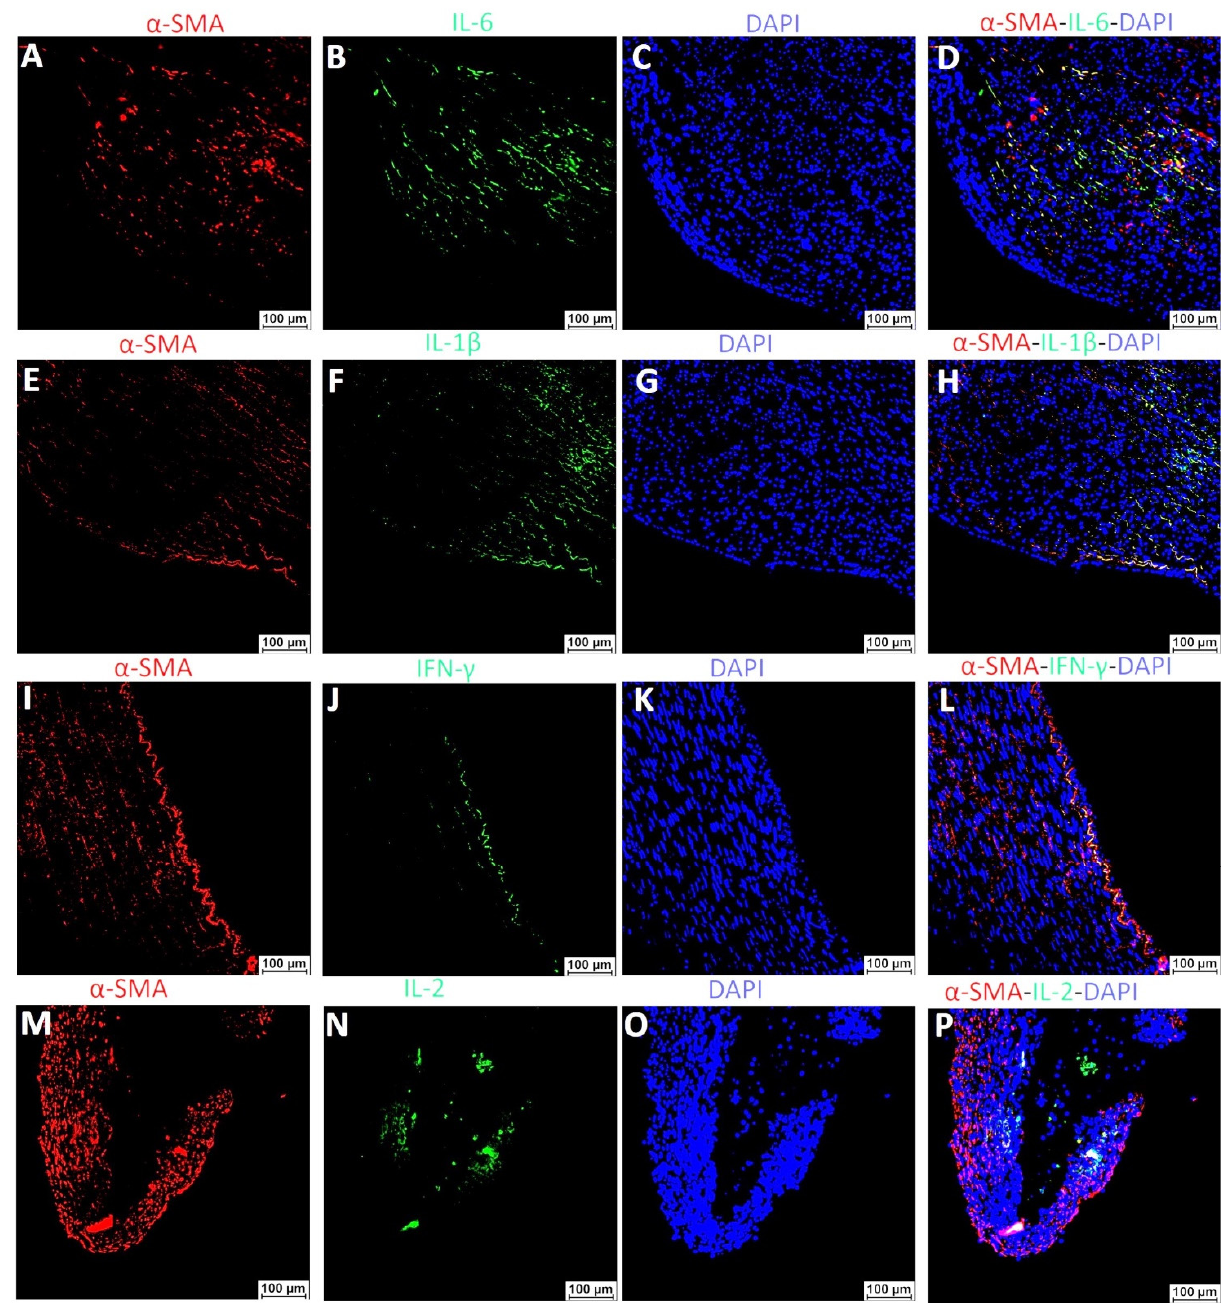
Figure 11. Dual ‐ immunofluorescence staining of arteries with a plaque for α‐ SMA and pro ‐ inflammatory cytokines IL ‐ 6, IL ‐ 1 β , TNF ‐α , and IL ‐ 2. Immunofluorescence for alpha ‐ smooth muscle actin ( α‐ SMA, panels A , E , I , M ), interleukin 6 (IL ‐ 6, panel B ), interleukin 1 β (IL ‐ 1 β , panel F ), tumor necrosis factor ‐ alpha (TNF ‐α , panel J ), interleukin 2 (IL ‐ 2, panel N ), 4 ′ ,6 ‐ diamidino ‐ 2 ‐ phenylindole (DAPI, panels C , G , K , O ), and merged images (panels D , H , L , P ). The arrows indicate dual positive cells while the arrowhead indicates immunopositivity for one protein. Additionally, dual ‐ immunofluorescence of control and plaque arteries showed higher immunopositivity for CD68, IL ‐ 6, IL ‐ 1 β , TNF ‐α , and IL ‐ 2 in arteries with plaque compared to control arteries. Further, co ‐ localized staining for CD68 with IL ‐ 6, IL ‐ 1 β , TNF ‐α , and IL ‐ 2 was also noted; however, all CD68 positive cells were not positive for IL ‐ 6, IL ‐ 1 β , TNF ‐α , and IL ‐ 2 (Figure 12).